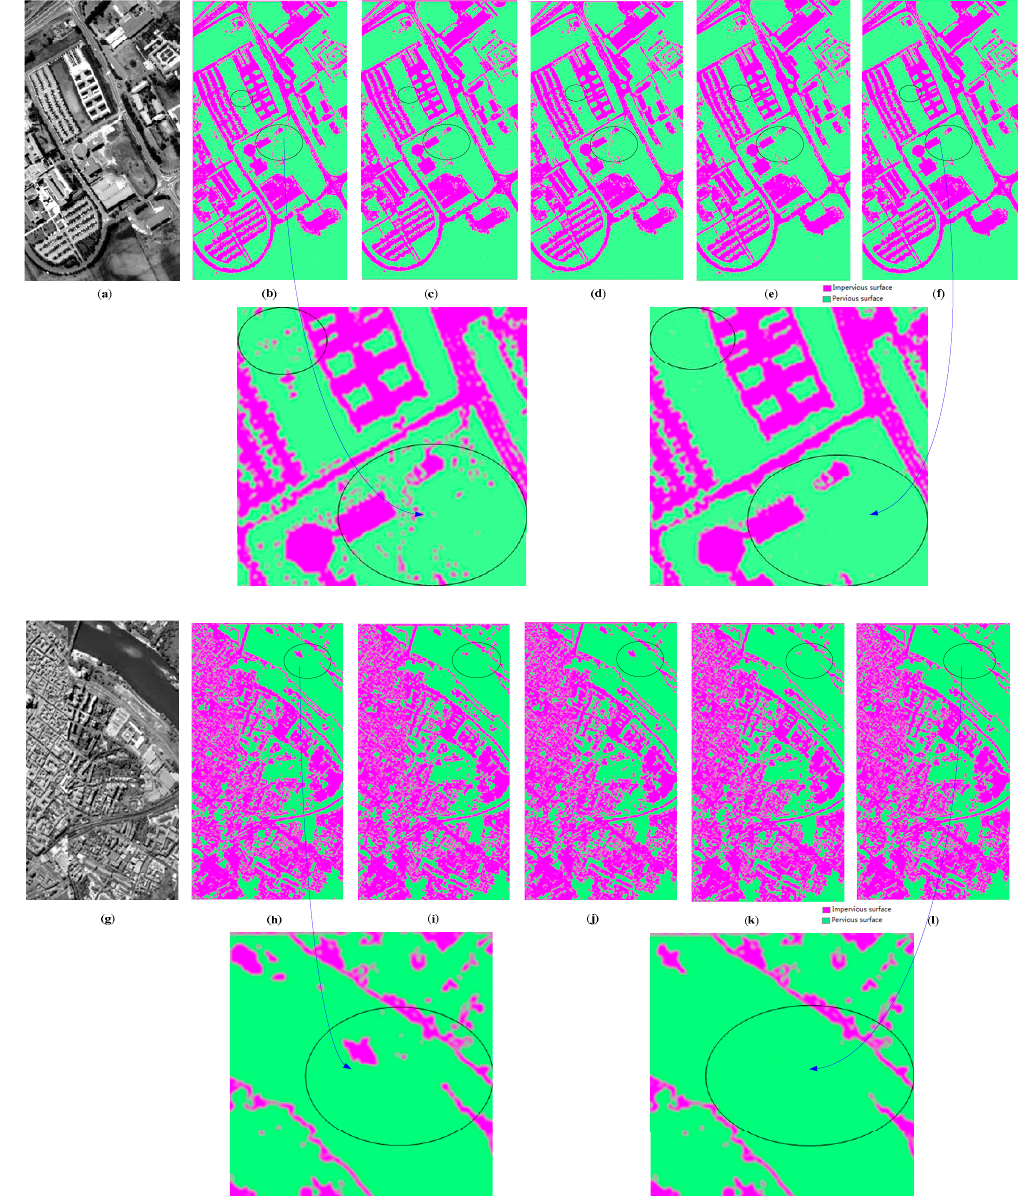
Figure 12. Results of impervious surface extraction use by successively SVM, CNNs, DBNs, CDBNs, and MFEM: ( a , g ) single band original image; ( b – f ) results of university scene; and ( h – l ) results of city center scene.